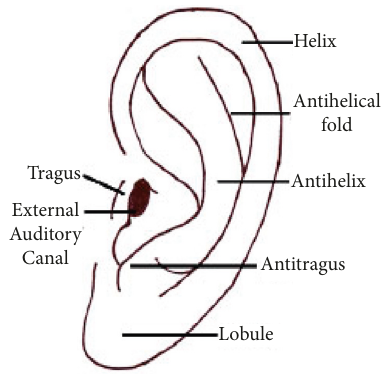
Figure 1: Diagram of the outer ear. Table 1: Summary of biometric